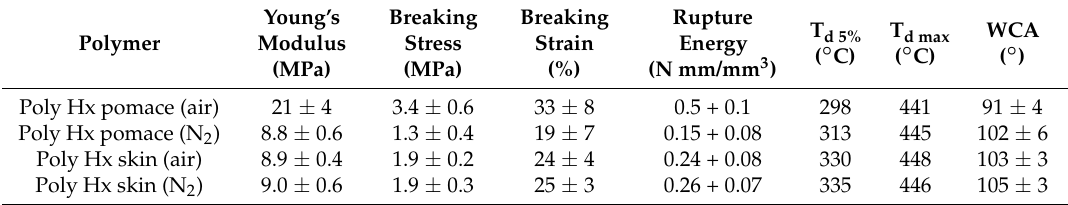
Table 3. Mechanical, thermal and wettability characterization of polymeric films obtained from Hx with and without the contribution from seeds and in oxidative and inert